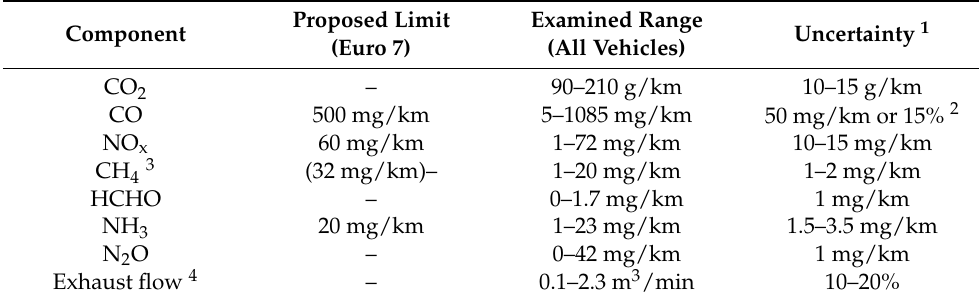
Table 4. Measured absolute uncertainty with the reference (BAG, DIL) and new techniques (IRLAM, FTIR), in comparison with the proposed Euro 7 limits. The values were based on the comparisons with the TLP.